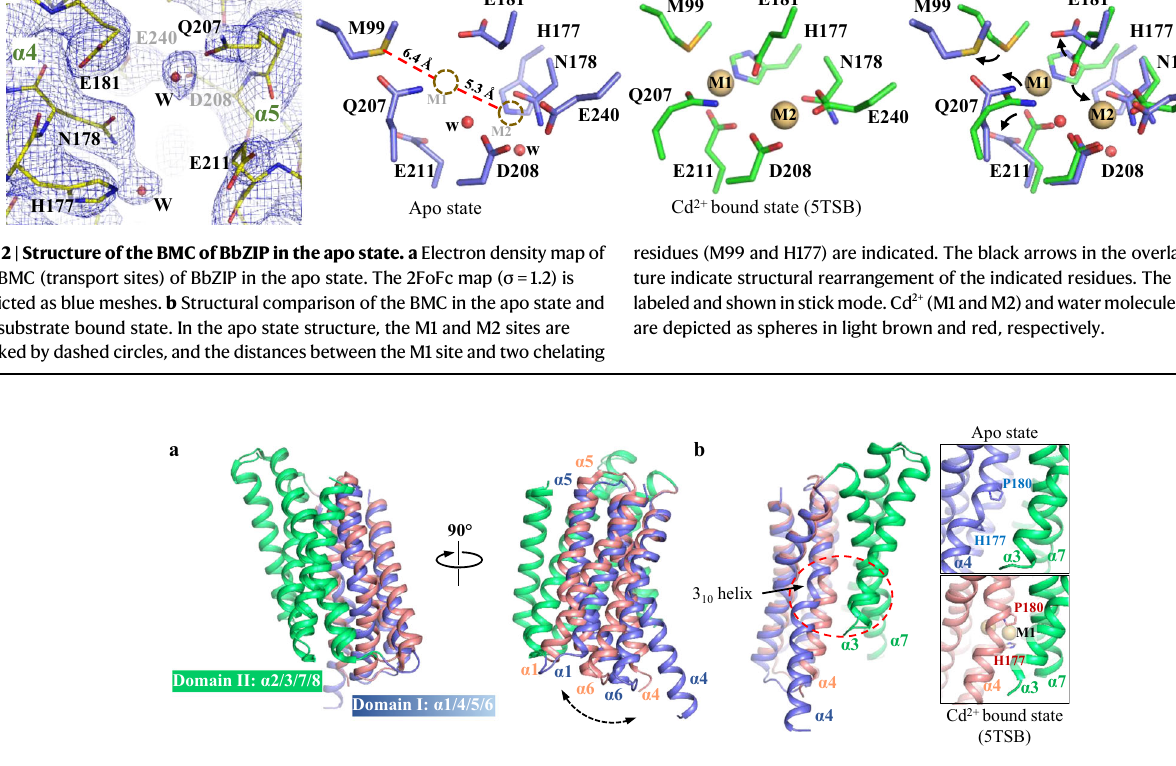
not shown. b Metal removal caused swing of α 4 (Domain I) away from α 3 and α 7 (DomainII).Thezoomed-inviewsoftheregioninthedashedredovalareshownon theright.H177andP180arelabeledanddepictedinstickmode.Thecadmiumions are shown as light brown